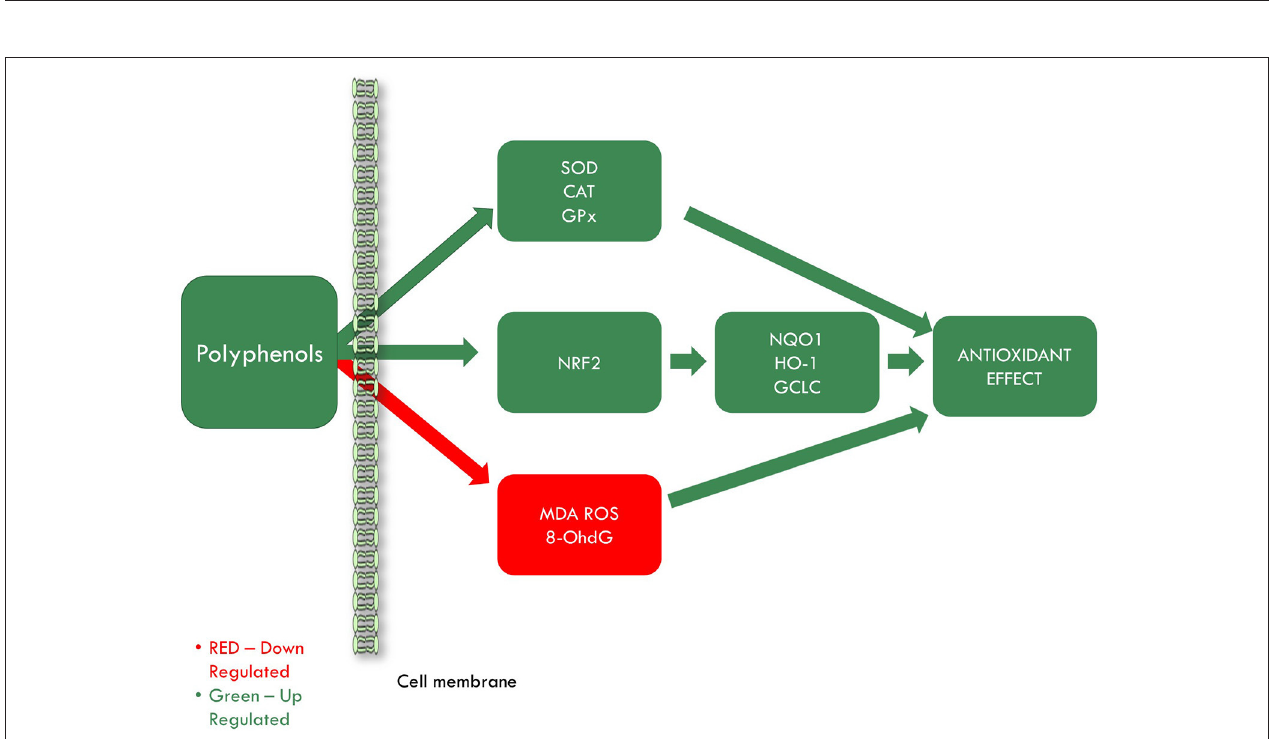
FIGURE 4 | Grapevine and wine by-products antioxidant effect in ischemic heart disease. SOD, superoxide dismutase; CAT, catalase; GPx, glutathione peroxidase; NRF2, nuclear factor erythroid 2–related factor 2; NQO1, quinone oxidoreductase-1; HO-1, heme oxygenase 1; GCLC, glutamate-cysteine ligase catalytic subunit; MDA, malondialdehyde; ROS, reactive oxygen species; 8-OhdG, 8-hydroxy-2 ′ -deoxyguanosine.